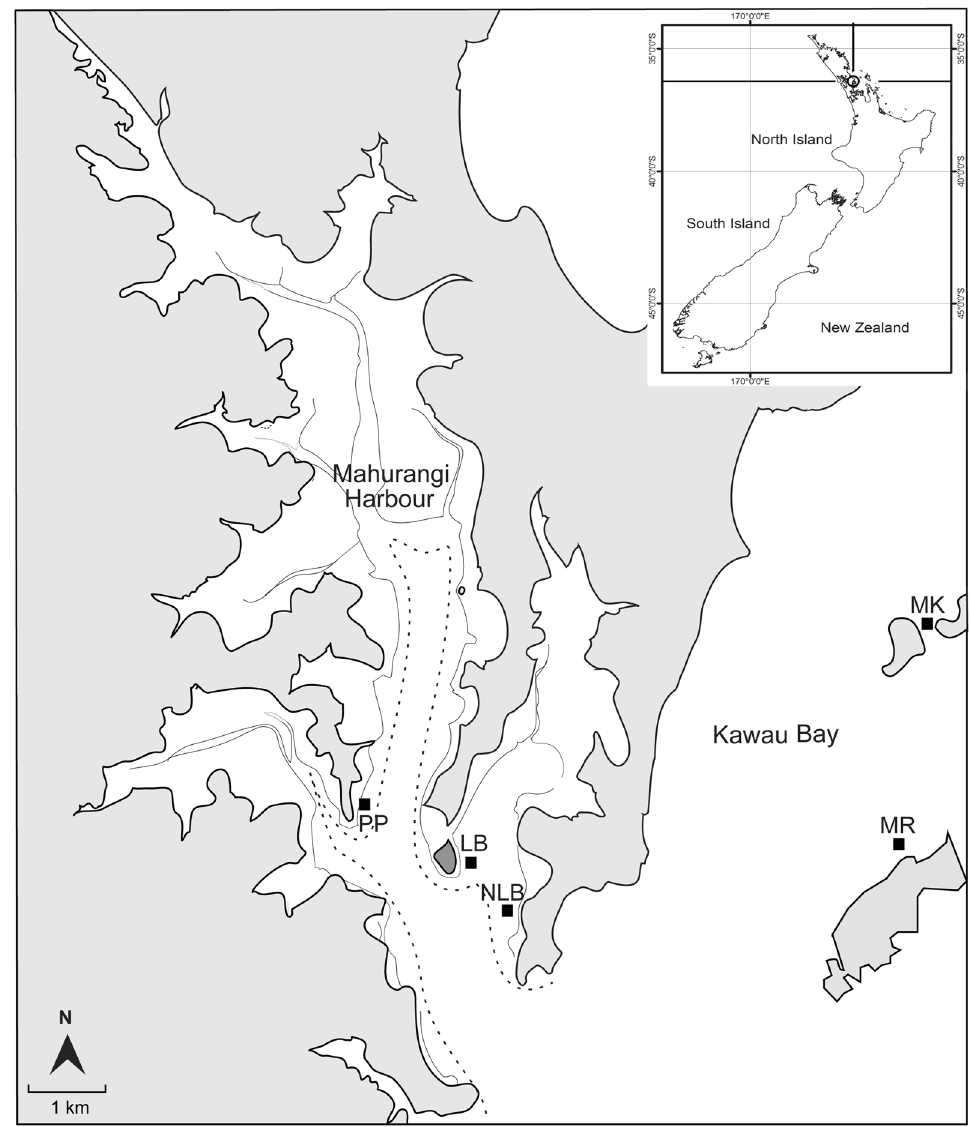
Figure 1. Each rectangle represents a paired study site, including a mussel bed and soft-sediment control (~ 5 m away), located either in Mahurangi Harbour or Kawau Bay, New Zealand. Pukapuka = PP, Lagoon Bay = LB, New Lagoon Bay = NLB, Motuora = MR, and Motoketekete =